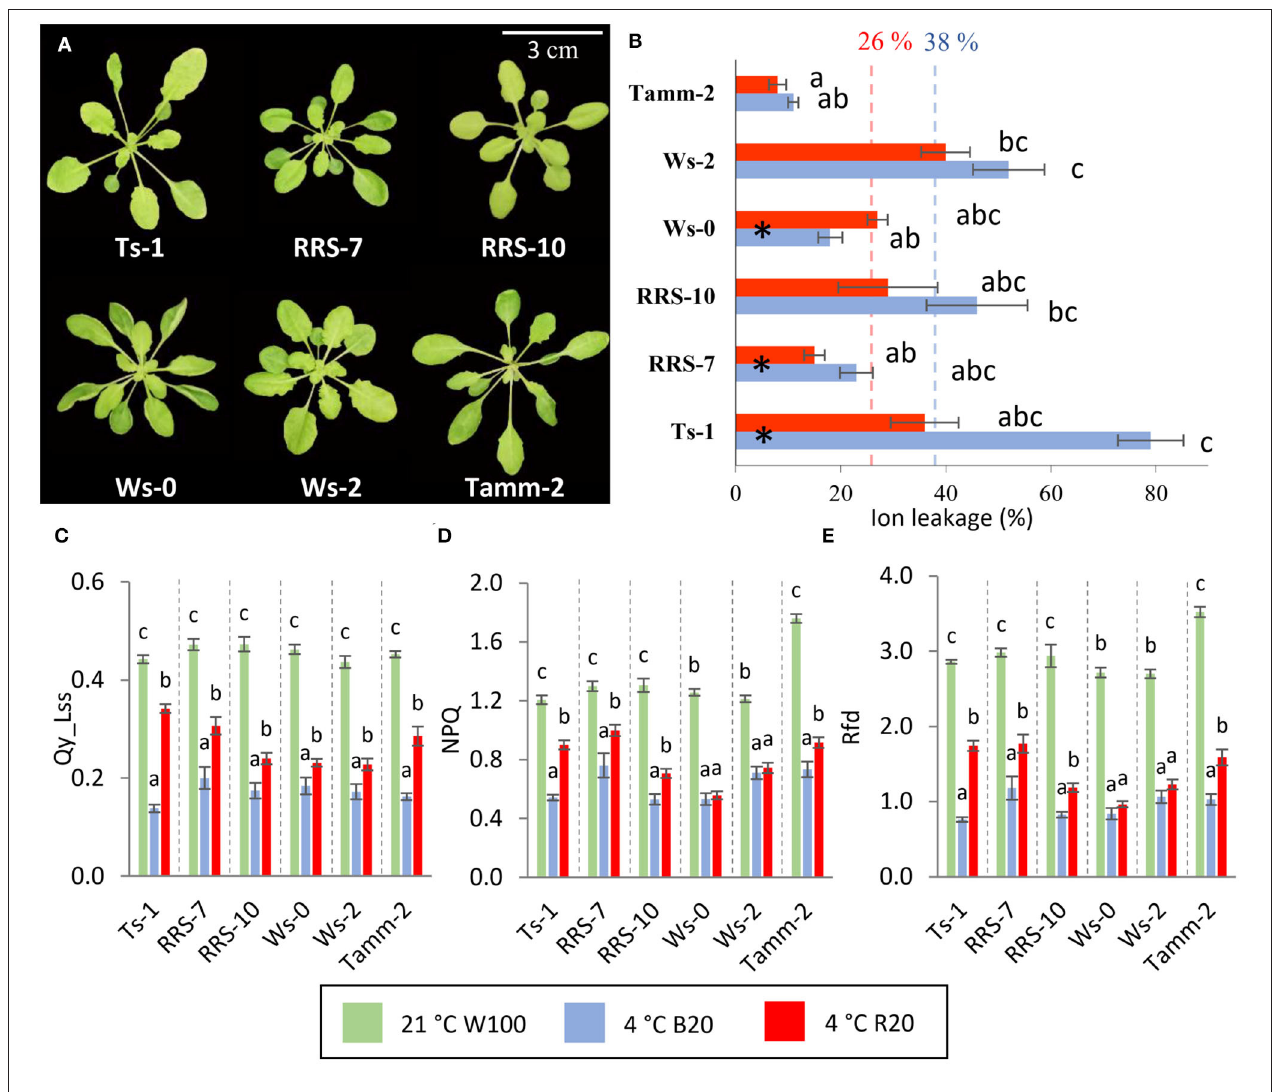
FIGURE 4 | Role of blue and red light in the cold-treated Arabidopsis accessions. (A) Representative images of 5 weeks old hydroponically grown Arabidopsis accessions grown in control conditions and used for cold treatment experiments. Plants were treated for 7 days at 4 ◦ C under 20 µ mol m − 2 s − 1 blue or red light. (B) Ion leakage of cold-treated plants in respective conditions. Results are means of three biological replicates, error bars indicate standard errors, and letters indicate significant differences according to the Kruskal–Walli’s test with post hoc analysis ( p < 0.05). Black asterisks in columns indicate significant differences between red and blue light cold-treated accession according to Student’s t -test ( p < 0.05). Colored dashed lines represent the average value of ion leakage for blue and red light cold-treated plants. (C) Quantum efficiency of photosystem II in light steady state, (D) non-photochemical quenching in light steady state, (E) photosynthetic parameter RFD. Results of photosynthetic parameters are means of three biological replicates, error bars indicate standard errors. The statistical significance of the results was evaluated separately for each accession. Letters indicate significant differences according to one-way ANOVA with Tukey’s HSD post hoc test ( p < 0.05). Accessions Ts-1, RRS-7, RRS-10, Ws-0, Ws-2, and Tamm-2 are described in Supplementary Material S4